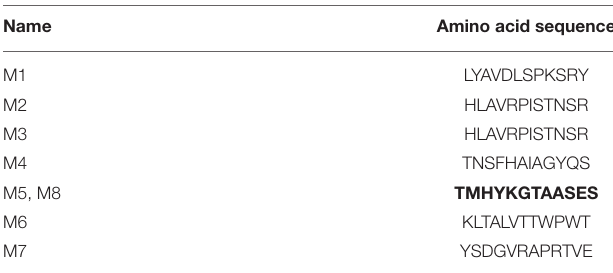
TABLE 2 | Results of DNA sequences for positive